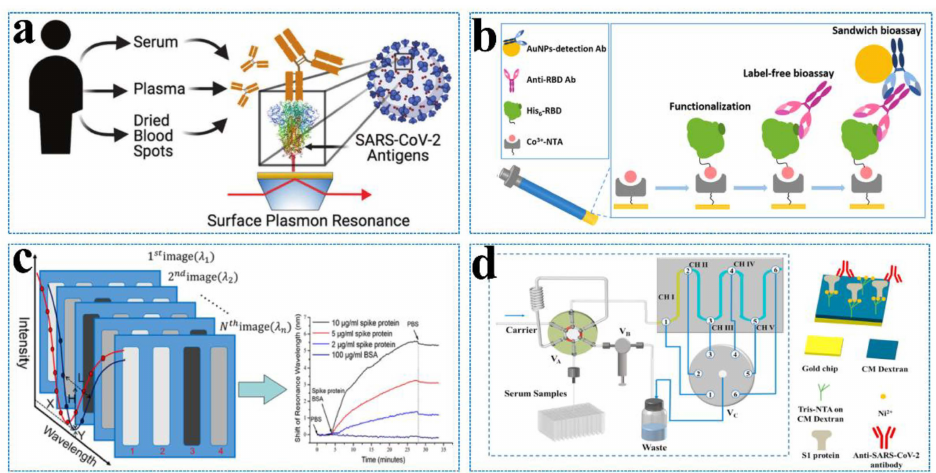
Figure 9. ( a ) A series of SPR sensors modified with different SARS-CoV-2 antigens (nucleocapsid, RBD, or spike) is applied to detect human antibodies from different blood products (serum, plasma, or dried blood spots) collected from COVID-positive or -negative individuals. Reprinted with permission from ref. [108]. ( b ) Label-free FO-SPR serological bioassays with sandwich formats for the detection of anti-SARS-CoV-2 RBD antibodies. Reprinted with permission from ref. [110]. Copyright 2022, American Chemical Society. ( c ) Schematic diagram of the fast wavelength interrogation SPR imaging biosensors. Reprinted with permission from ref. [111]. Copyright 2021, American Chemical Society. ( d ) Schematic of the five-channel SPR system with an autosampler for detecting the anti- SARS-CoV-2 antibody in serum samples (left). Captures of the anti-SARS-CoV-2 antibody by the His-tagged S1 protein pre-immobilized onto the CM-dextran-based tris-NTA sensor (right). Reprinted with permission from ref. [112]. Copyright 2022,